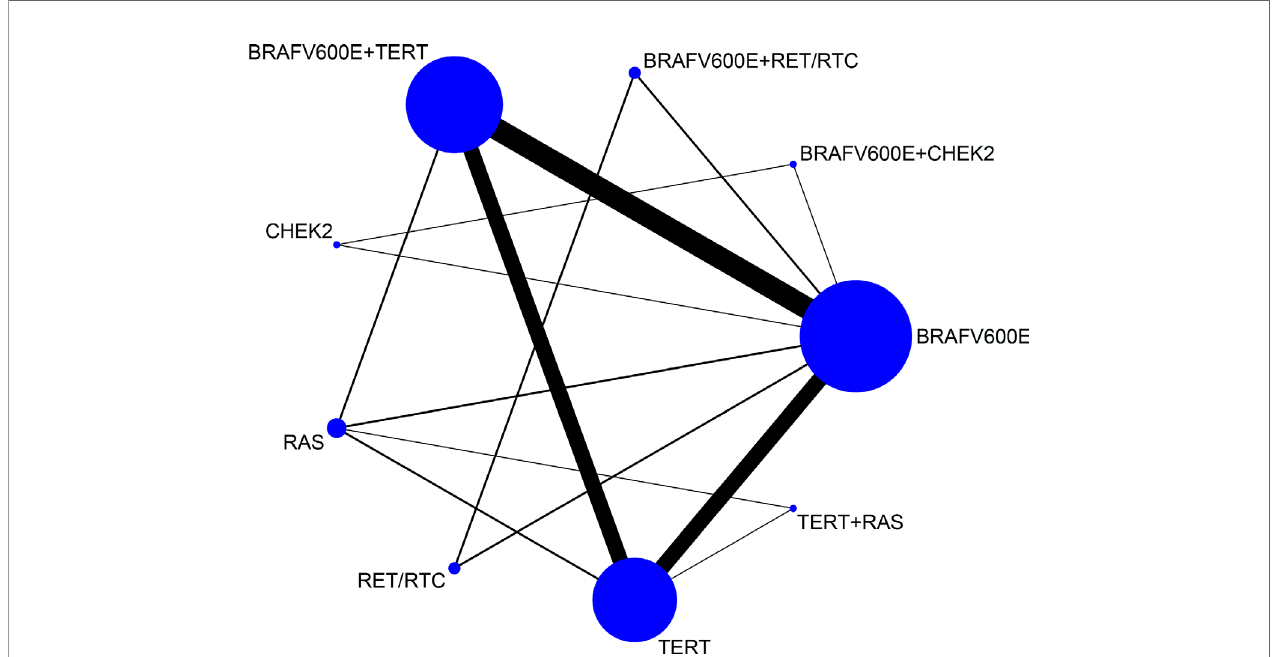
FIGURE 2 | Network meta-analysis plots relating to the eligible comparisons of lymph node metastasis outcomes. Each circular node represents a coexistent or single genetic mutation. The circle size is proportional to the total number of patients with thyroid carcinoma, while the line width is proportional to the number of studies used in the head-to-head